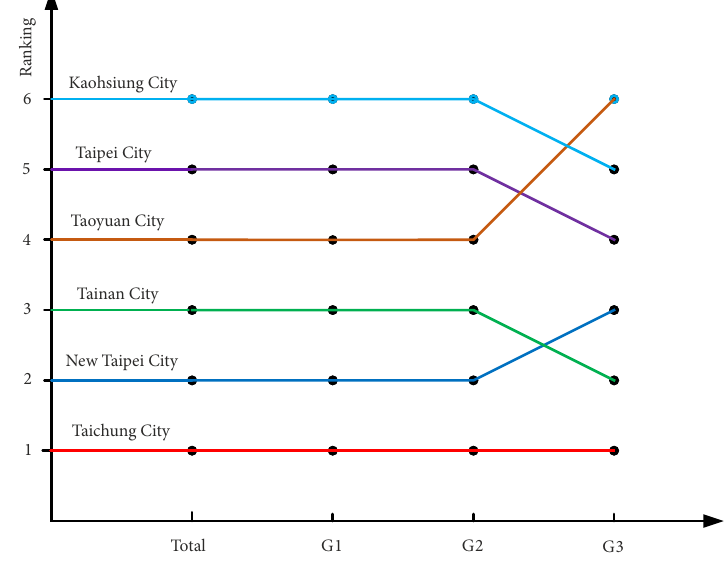
Figure 5. Ranking of the six cities for different groups in technological capability aspect